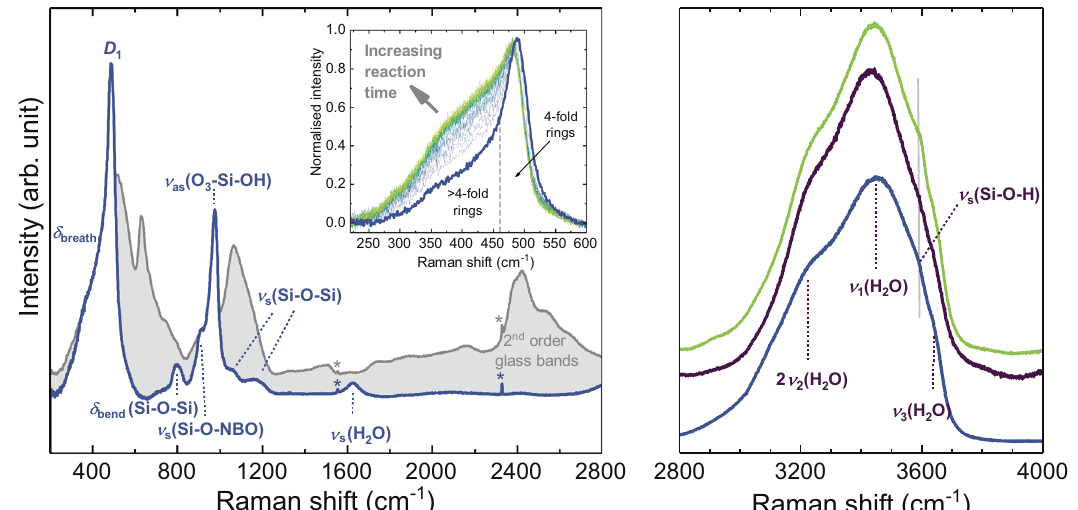
Fig. 2 Structural changes in amorphous silica. Representative background-corrected Raman spectra from amorphous silica (blue spectrum) formed within the fi rst hours of the experiment near the glass surface, and from the silicate glass (light grey spectrum), showing the typical glass bands with second-order bands between 2300 and 2900 cm − 1 . Raman modes for silica are assigned after Aguiar et al. 28 . The stars (*) mark bands from O 2 (1555 cm − 1 ) and N 2 (2331 cm − 1 ) of the air between glass and objective. Inset diagram shows a series of Raman spectra in the frequency range between 200 and 600 cm − 1 that were taken at different times at the same location (cf. Fig. 3a). The blue and yellow spectra represent the fi rst and last measurement at that location, respectively. Note that with increasing reaction time, the intensity near 430 cm − 1 increases signi fi cantly, re fl ecting the formation of fi ve- and sixfold silica rings with time. Moreover, the ν s (SiO – H) band is not visible in all spectra (purple spectrum), indicating an inhomogeneous distribution of silica inner surface OH groups that are linked via hydrogen to a water molecule (cf. Fig.